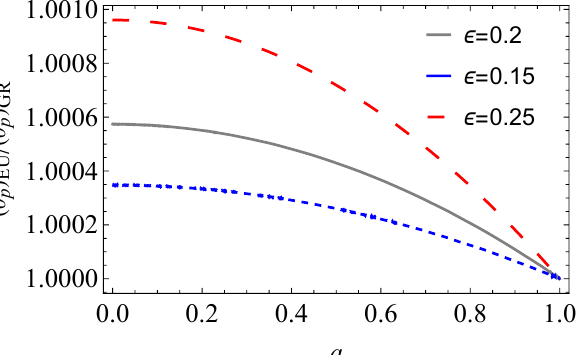
Figure 4. The angle Θ of the polar cap region of NSs as a function of the EU parameter for various values of (cid:101)